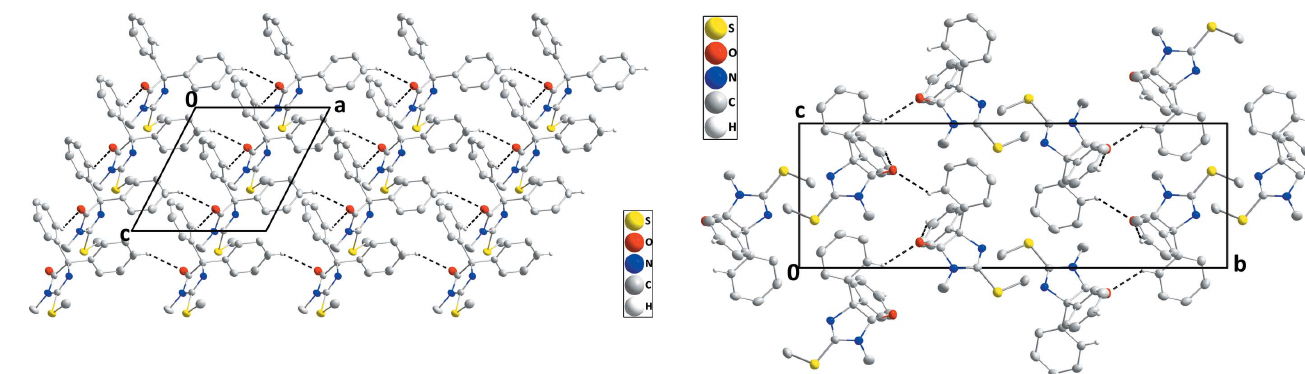
Figure 3 Packing viewed along the a -axis direction giving end views of parts of four layers with C—H (cid:2)(cid:2)(cid:2) O hydrogen bonds depicted by dashed lines. Non- interacting hydrogen atoms are omitted for clarity.